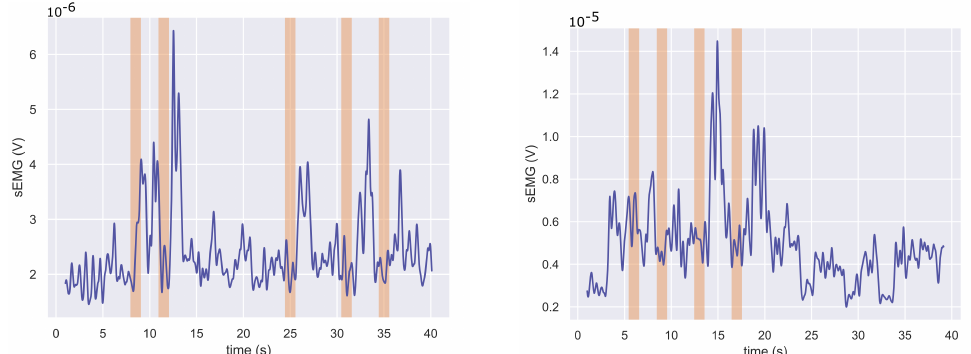
Figure 7. The sEMG envelope of data captured at the trapezius muscle of Participant1 during two trials (Trial1 on the left and Trial2 on the right ).